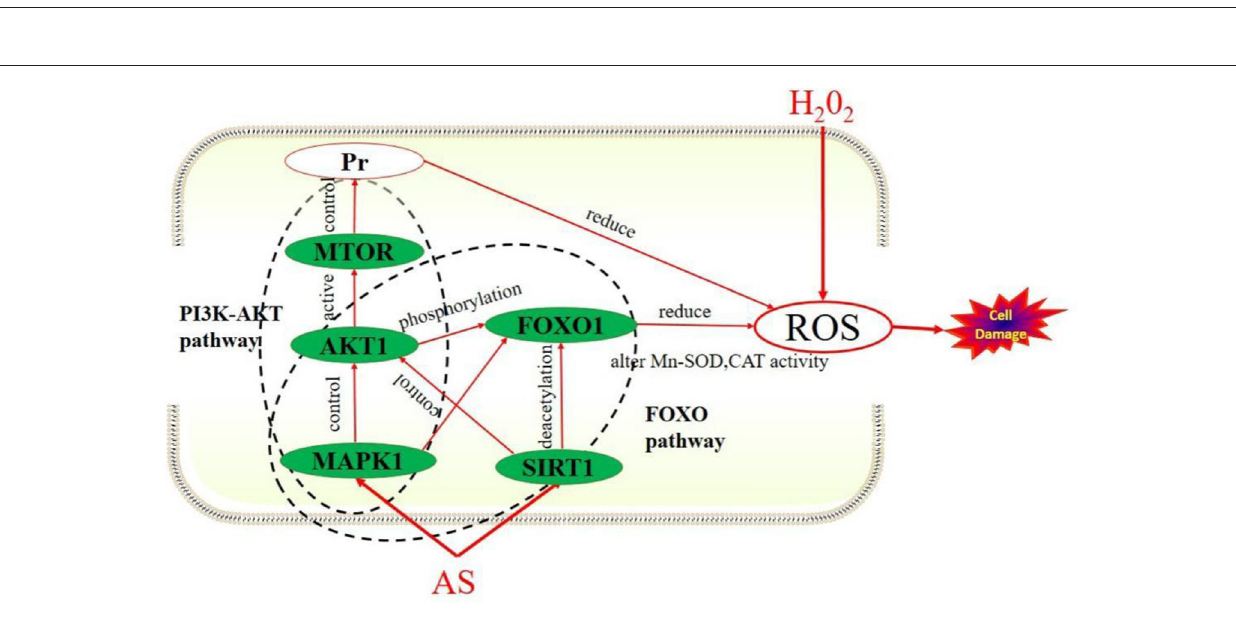
FIGURE 10 | How AS exerts antioxidant